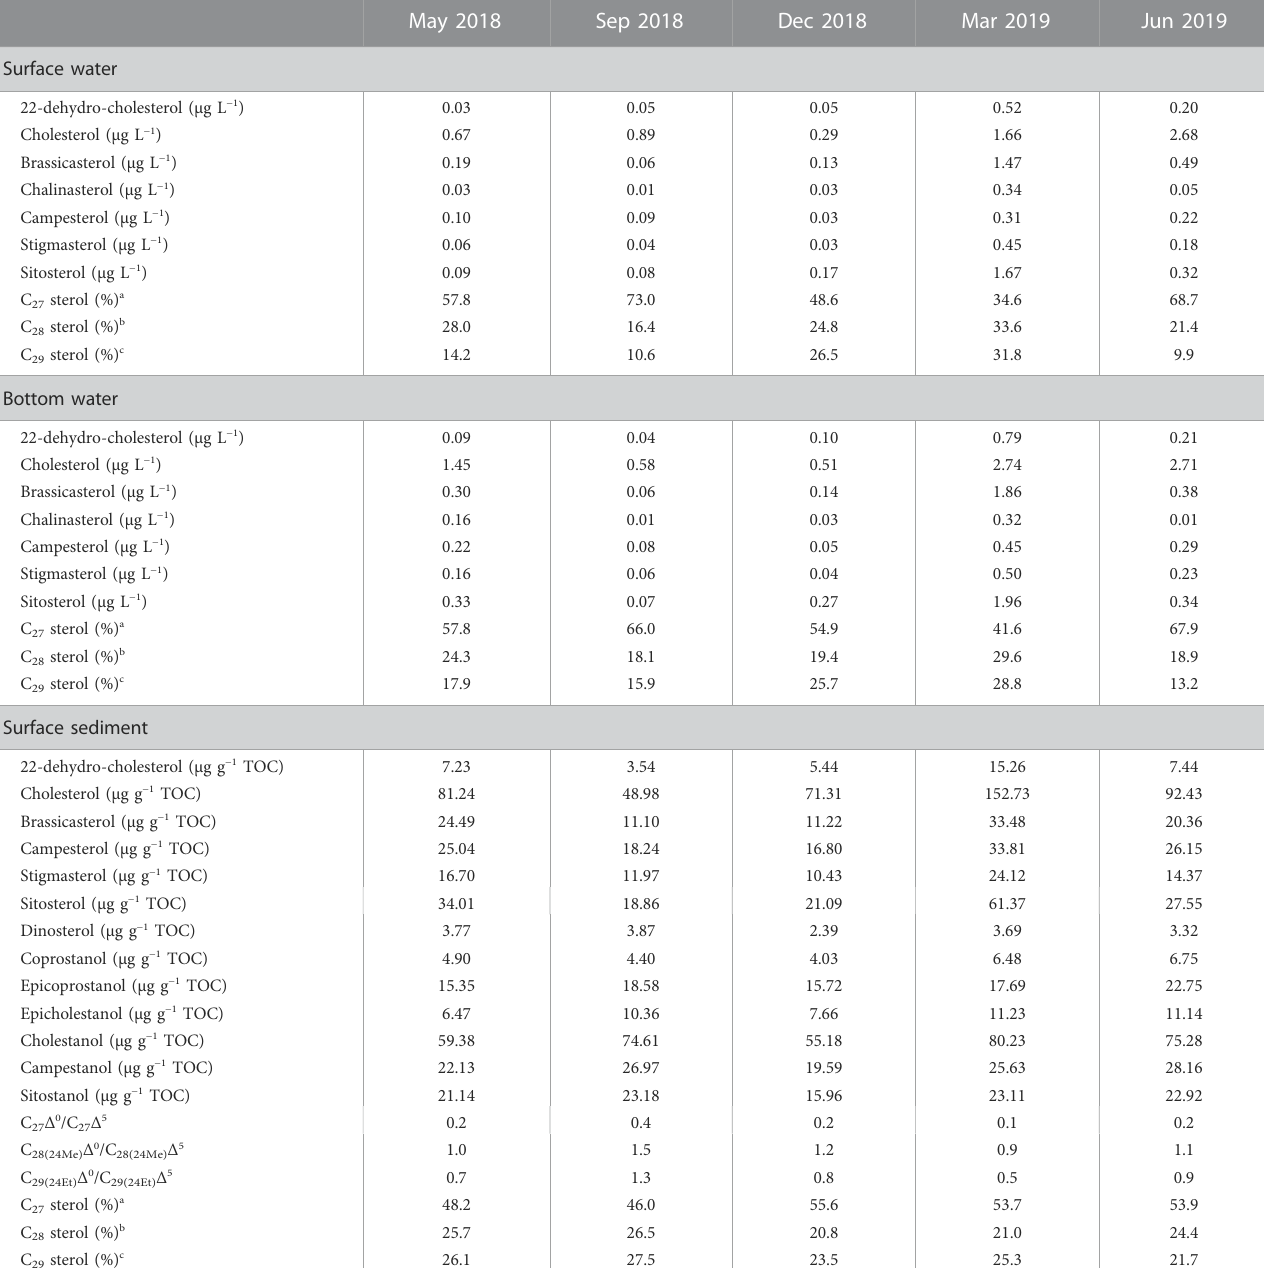
TABLE 2 Biomarker concentrations and parameters for surface and bottom water particulate organic matter and surface sedimentary organic matter in different